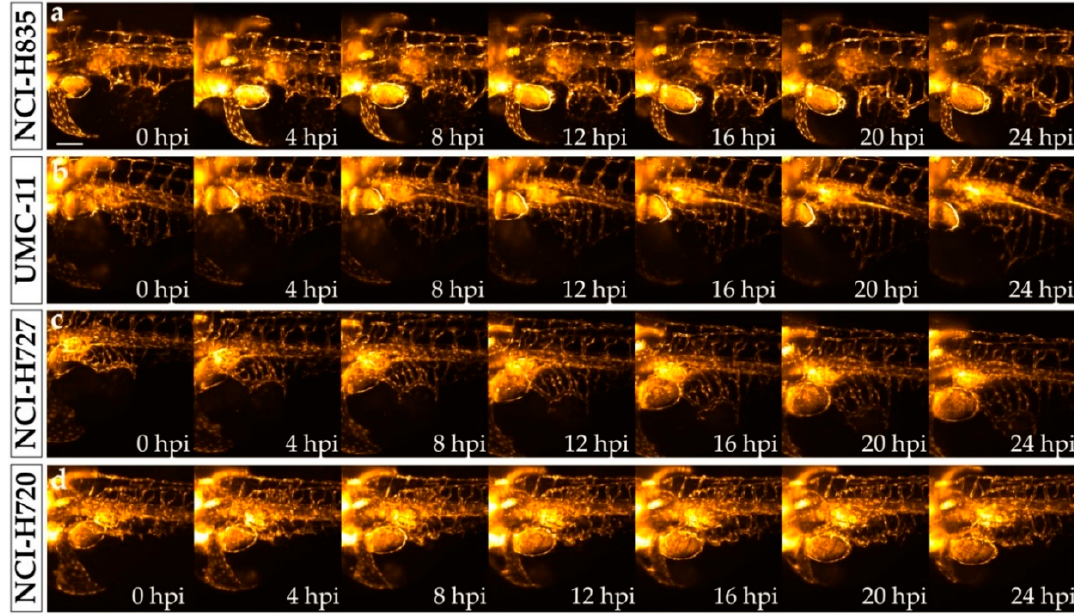
Figure 4. Time-lapse imaging of lung carcinoid cell grafted embryos performed with selective plane illumination microscopy. Representative maximum intensity projections of volumetric stacks acquired of Tg(fli1a:EGFP) y1 zebrafish embryos at the level of the graft regions captured every 4 h until 24 hpi. Embryos were implanted with NCI-H835 ( a ), UMC-11 ( b ), NCI-H727 ( c ), and NCI-H720 ( d ) cells. Embryos are shown anterior to the left. Scale bar: 100 µm.